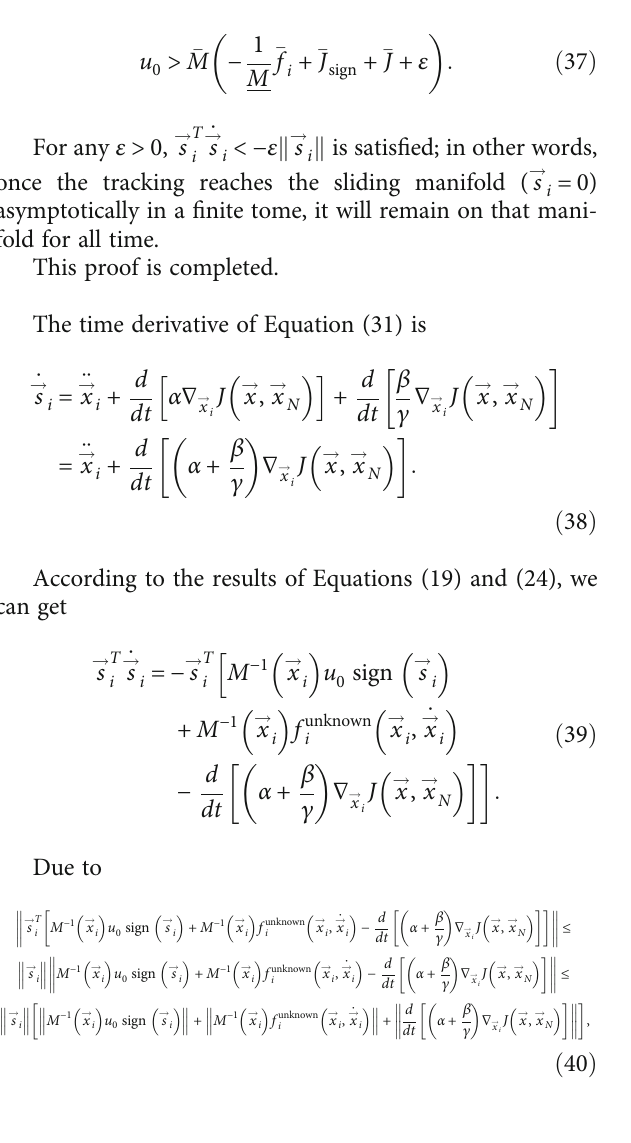
Figure 2: The tracking trajectories of proposed